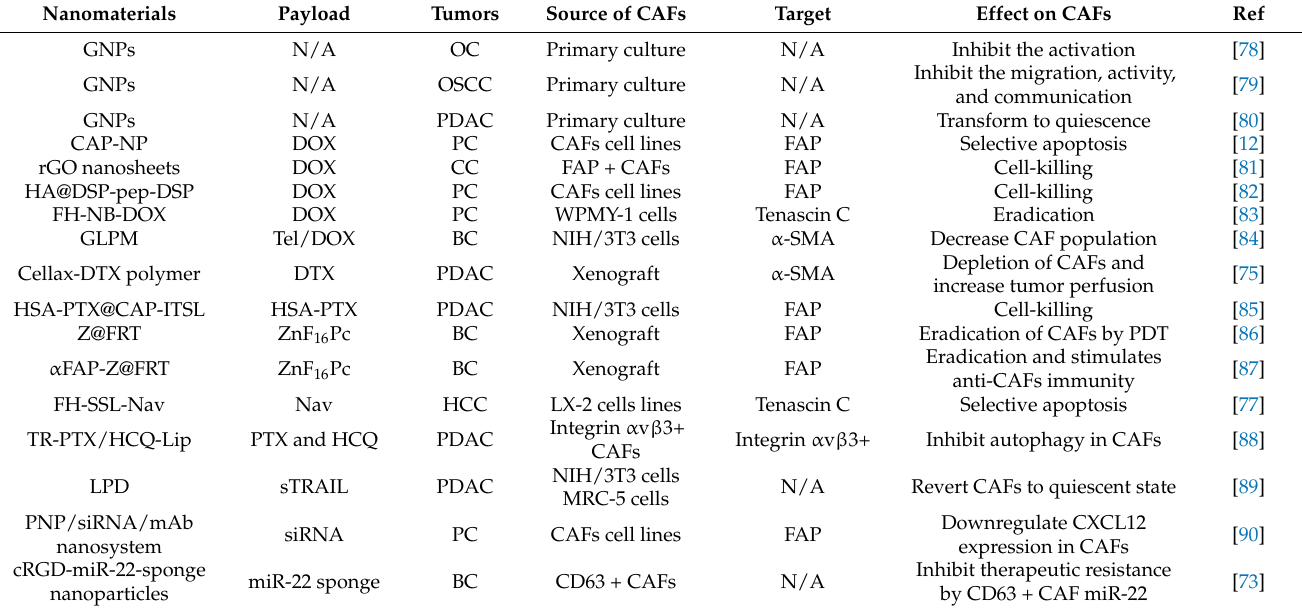
Table 3. Nanoparticle targeted cancer-associated fibroblasts in anti-cancer